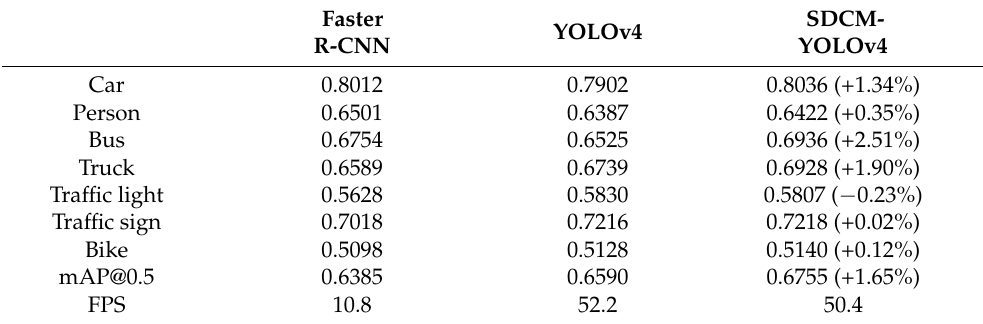
Table 2. Object detection accuracy comparison of Faster R-CNN, YOLOv4 and YOLOv4-SDCM on BDD100K data